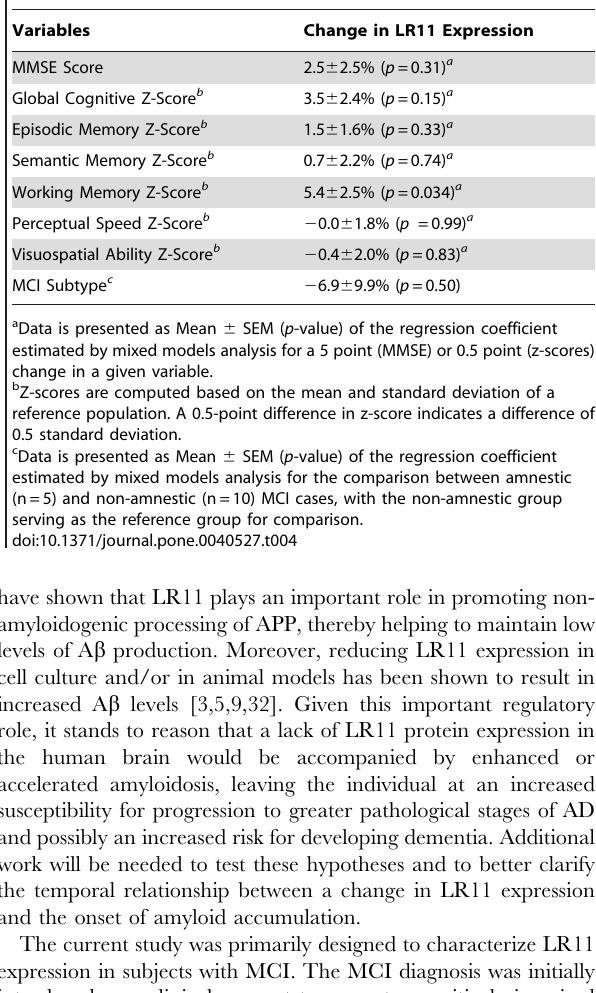
Table 5. All three diagnostic groups are pathologically AD-like.